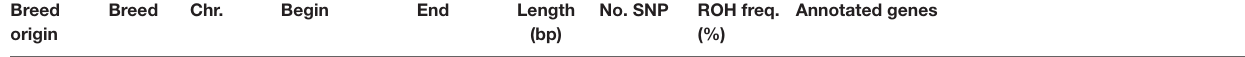
TABLE 3 | Chromosomal position, length, number of markers, and gene content of runs of homozygosity (ROH) islands shared by more than 50% (ROH freq.) identified in taurine (JER), indicine (BRA, IND, and TAB), and locally adapted (CCD, CCB, and CUR) breeds. Breed Breed origin